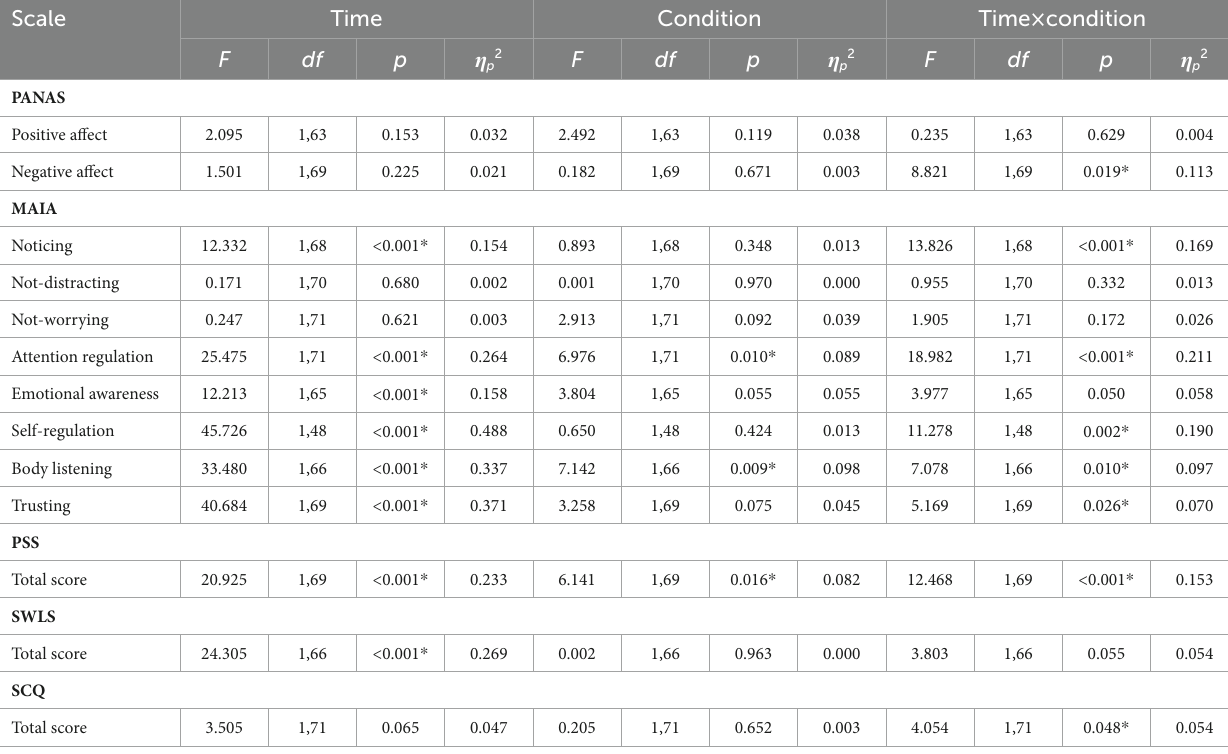
TABLE 2 Effects of the intervention on positive and negative affectivity, interoceptive awareness, perceived stress scale, satisfaction with life and spiritual connection. Scale Time